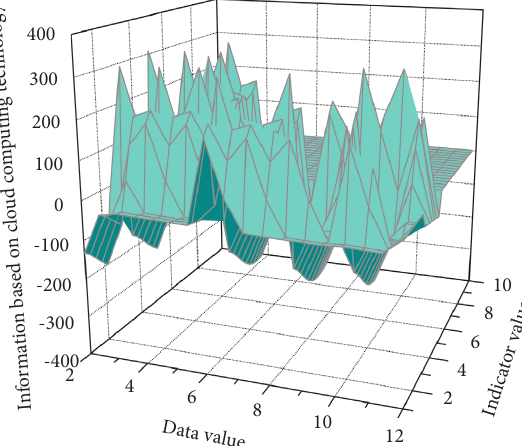
Figure 7: Information convergence based on cloud computing